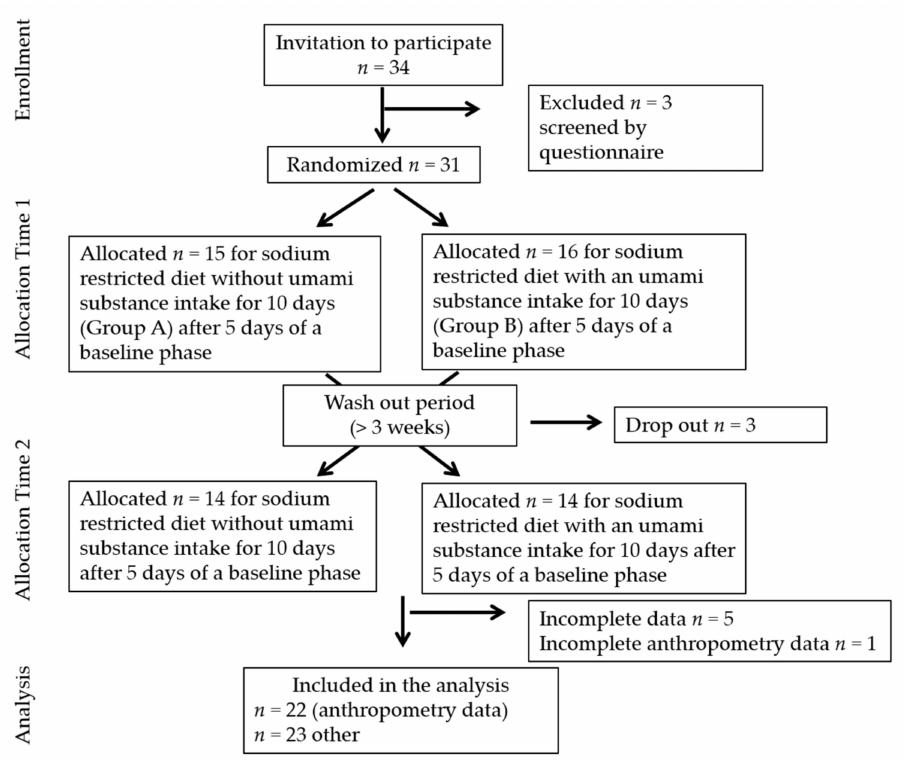
Figure 1. CONSORT diagram showing the flow of participants through each stage of the study. The dietary composition of sodium, potassium, and free L-glutamate is shown in Table 1, according to the food analyses at the laboratory of Ajinomoto Co., Inc. The baseline diet had 4612 ± 177 mg/d of sodium, and the sodium-restricted diet of the control group had 1993 ± 235 mg/d and the Glu group had 2048 ± 250 mg/d of sodium. Table 1. Characteristics of the diet for the baseline and the sodium-restricted diets. Sodium-Restricted Diets Baseline Diet Control Group Glu Group Mean SD Mean SD Mean SD 0.02 0.36 0.06 1.10 0.65 2048 250 2807 656 2149 209 1984 37